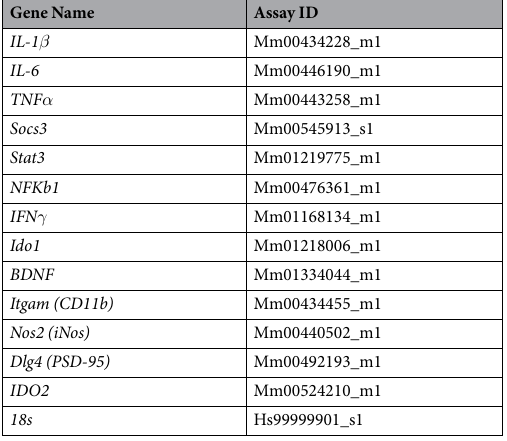
Table 1. Gene names and assay ids for TaqMan primer/probe sets used throughout the